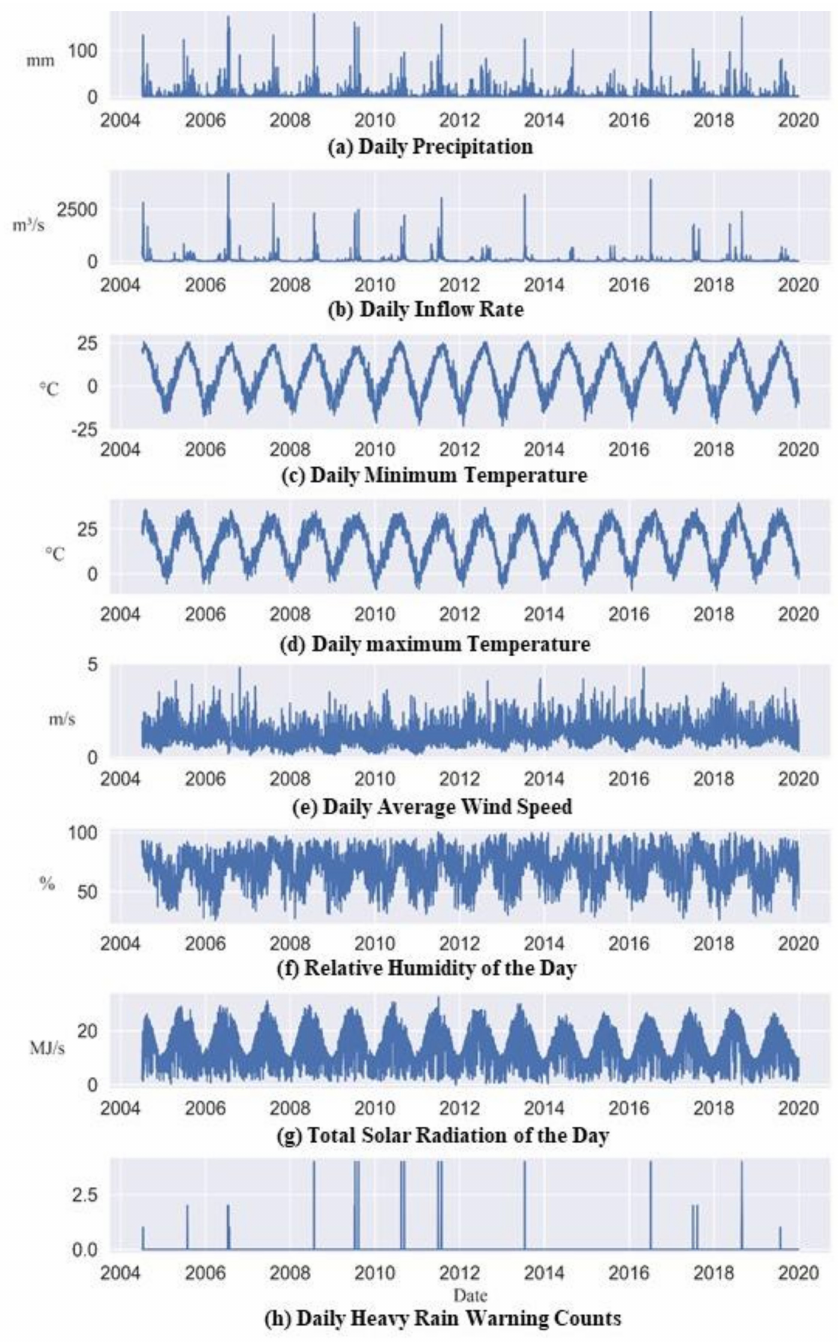
Figure 1. Time series data of dam inflow and